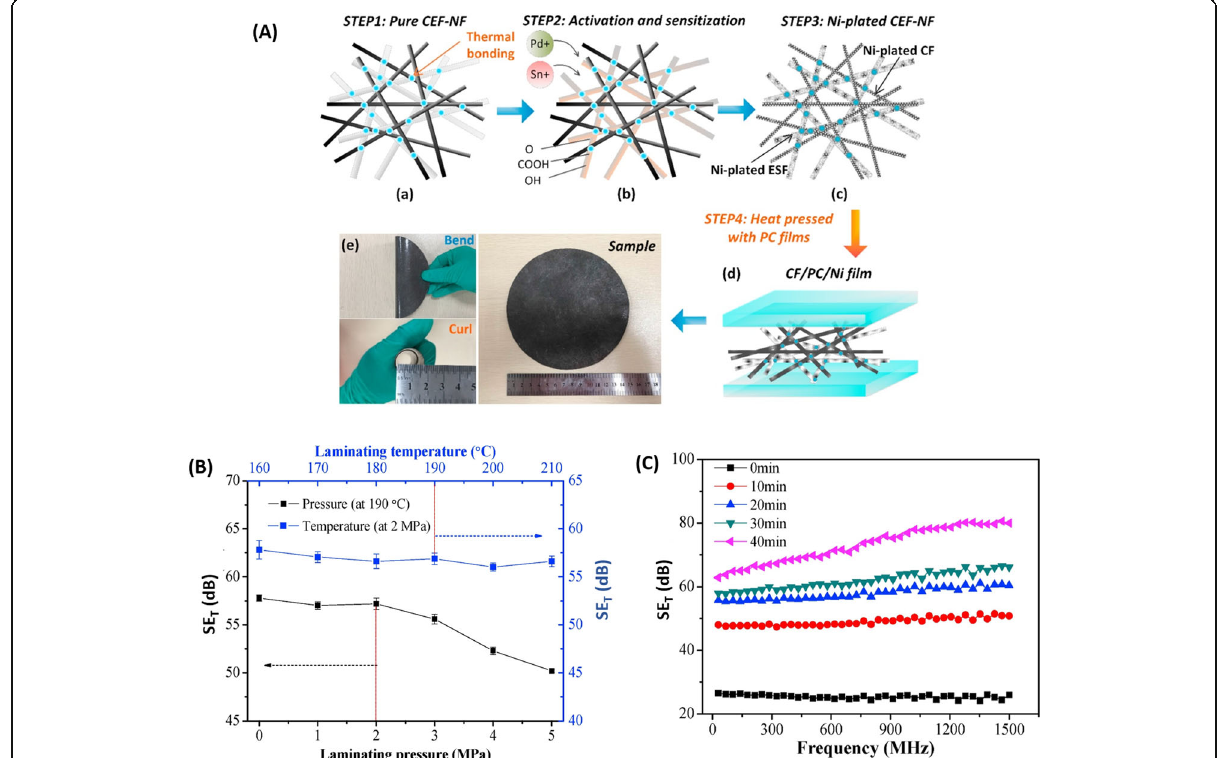
Fig. 19 (A) (a - d) Schematic of the CF/PC/Ni film preparation ( e ) as-fabricated CF/PC/Ni films subjected to bending and curling; ( B ) Effect of laminating pressure and temperature on the SE T of CF/PC/Ni films; ( C ) SE T of CF/PC/Ni films with different Ni plating times. Adapted with permission from Tang et al. [33], copyright 2018